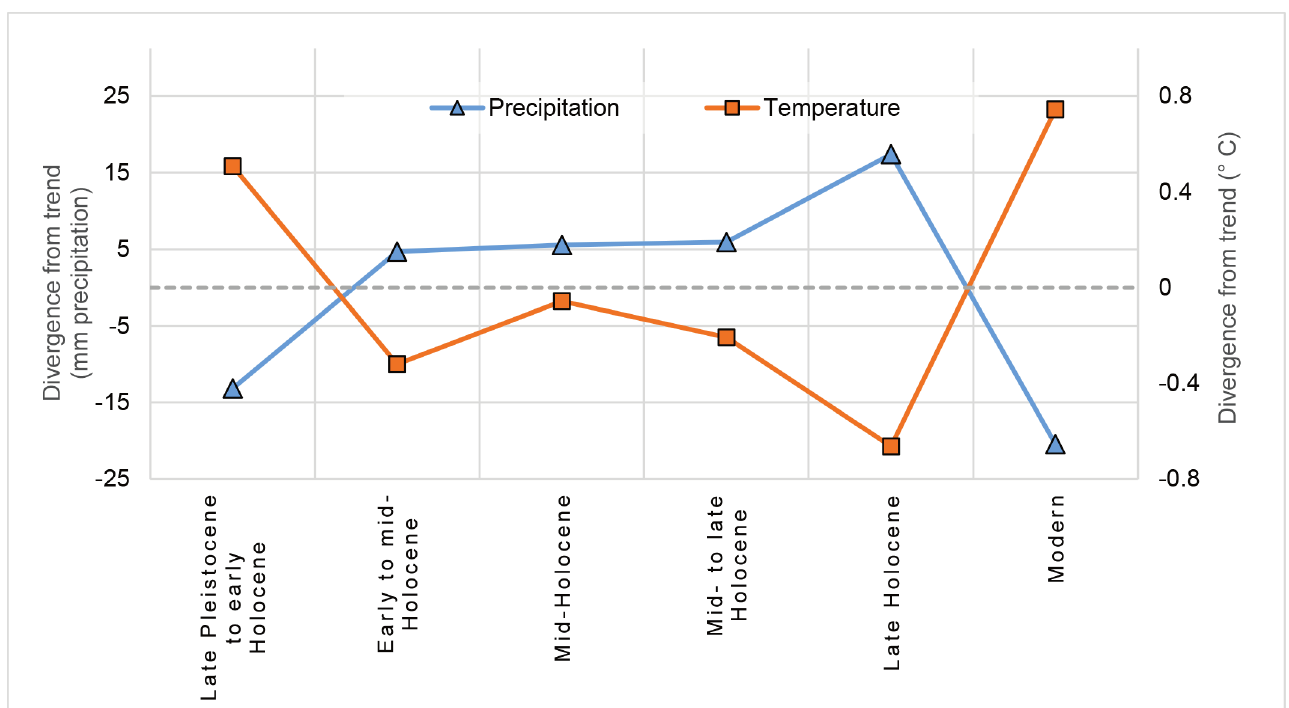
Figure 2. Divergence of predicted climatic values at riparian sites in southwestern Alberta from linear model (seen in Figure 1). Horizontal dashed line represents the trend (i.e., 0